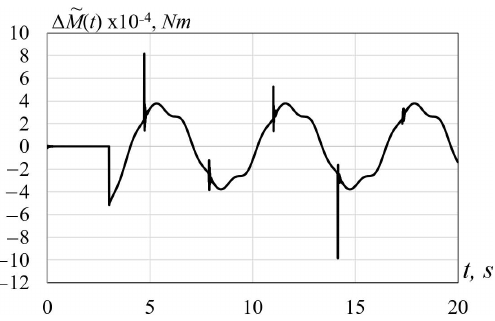
Figure 3. Behavior of the estimation error ∆ ˜ M ( t ) = ˜ M ( t ) − M ( t )